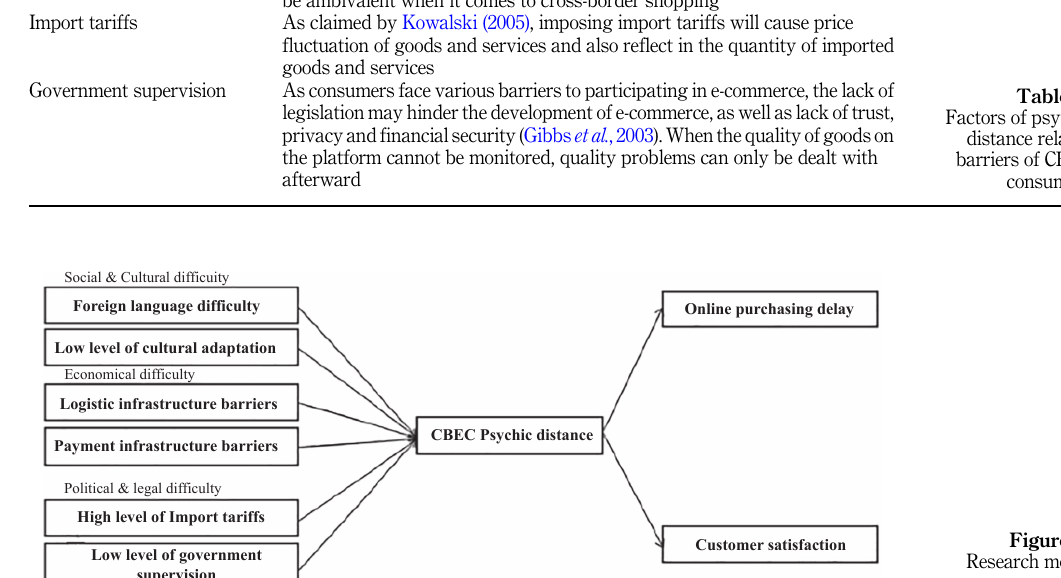
Figure 3. Research